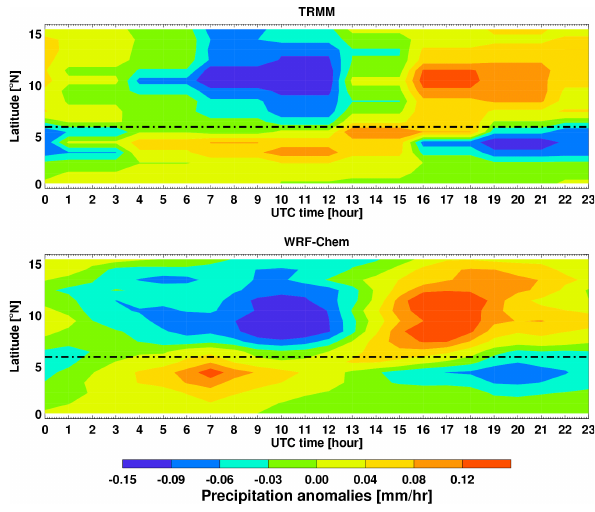
Figure 6 Diurnal anomalies of zonal averaged precipitation between 15 o W-10 o E from 6 Fig. 6. Diurnal anomalies of zonal averaged precipitation between 15 ◦ W–10 ◦ E from TRMM measurements and the WRF-Chem sim- TRMM measurements and the WRF-Chem simulation with dust. The TRMM data are 7 ulation with dust. The TRMM data are shown in 3-h temporal res- shown in 3-hour temporal resolution. The dashed line shows the Guinean coast. The 8 olution. The dashed line shows the Guinean coast. The diurnal anomalies are calculated by subtracting the daily mean precipita- diurnal anomalies are calculated by subtracting the daily mean precipitation from hourly 9 tion from hourly precipitation. 10